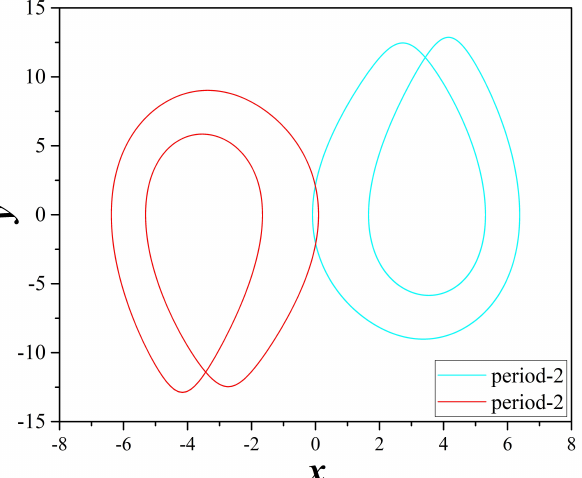
Figure 12. Coexisting attractors of system (2), for a = 4 × 10 − 4 , b = 1, c = 3.846 × 10 − 4 , e = 1 and d = 15. With cyan color and for ( x 0 , y 0 , z 0 ) = ( 0,0.1,0 ) a period-2 attractor, while with red color and ( x ) = ( − 5.3107692,0,1.7241613 ) a symmetric period-2 0 , y 0 , z 0